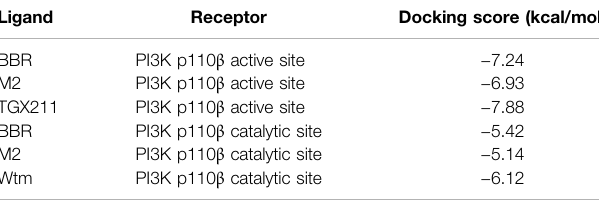
TABLE 1 | Docking scores of different ligands binding with PI3K p110 β